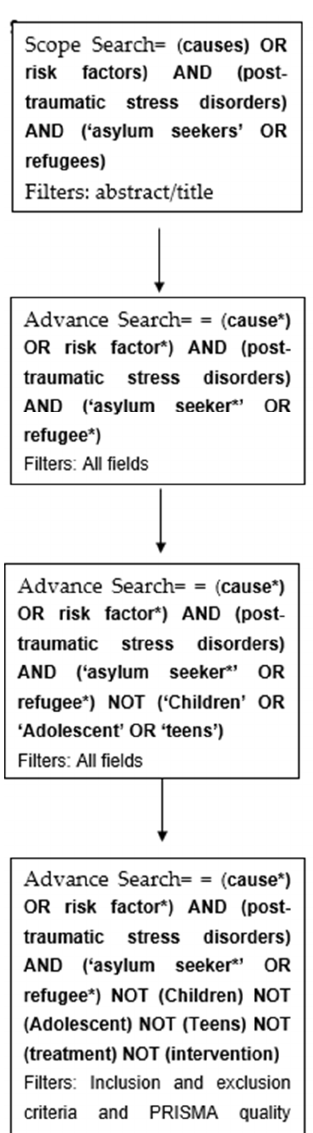
Figure 1. A step-by-step guide to search terms and Boolean operators applied in PubMed/Web of Science/Scopus.